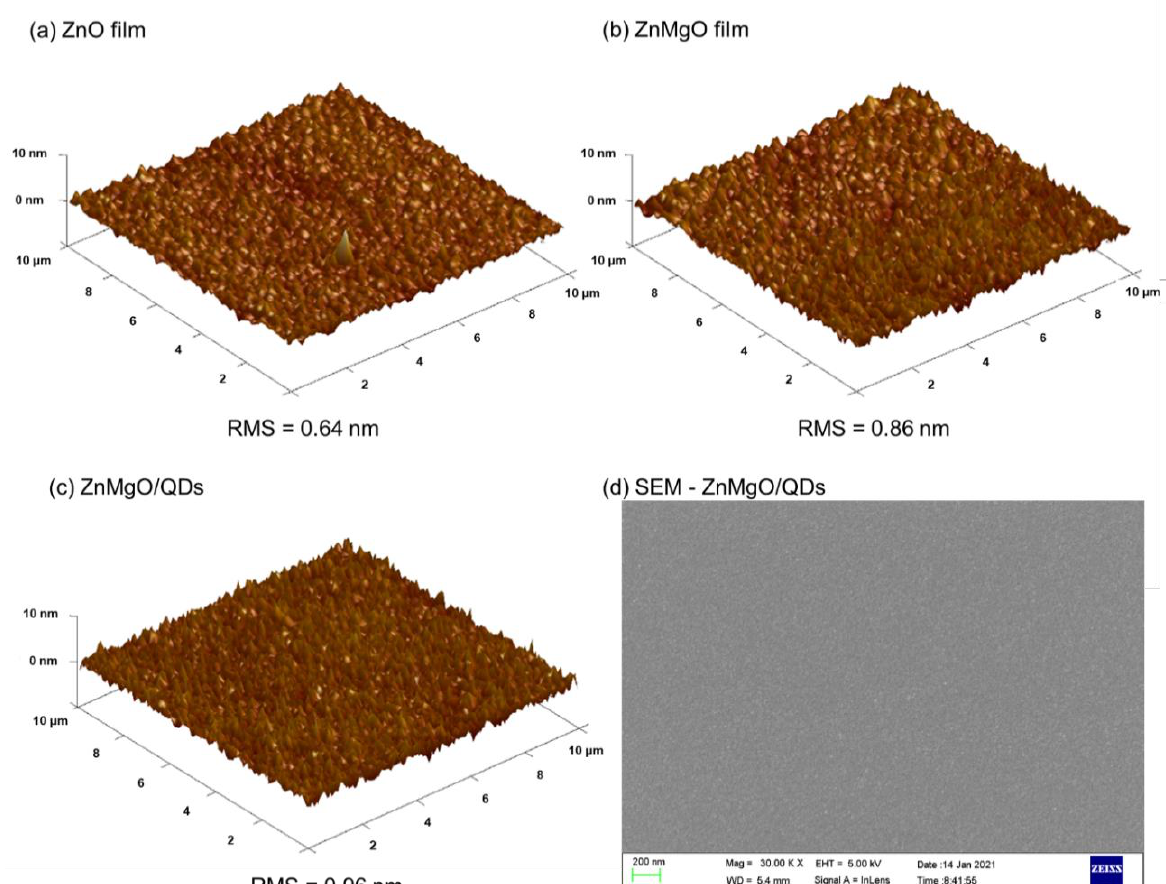
Figure 2. The 3D AFM images of ( a ) ZnO film, ( b ) ZnMgO film, and ( c ) ZnMgO/QDs multilayer surface; ( d ) SEM image of ZnMgO/QDs multilayer surface.